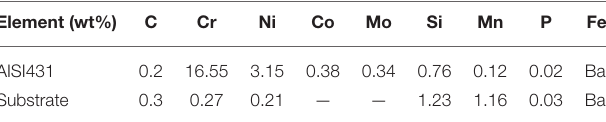
TABLE 2 | Processing parameter for LMD and EHLMD experiments. Method Laser power